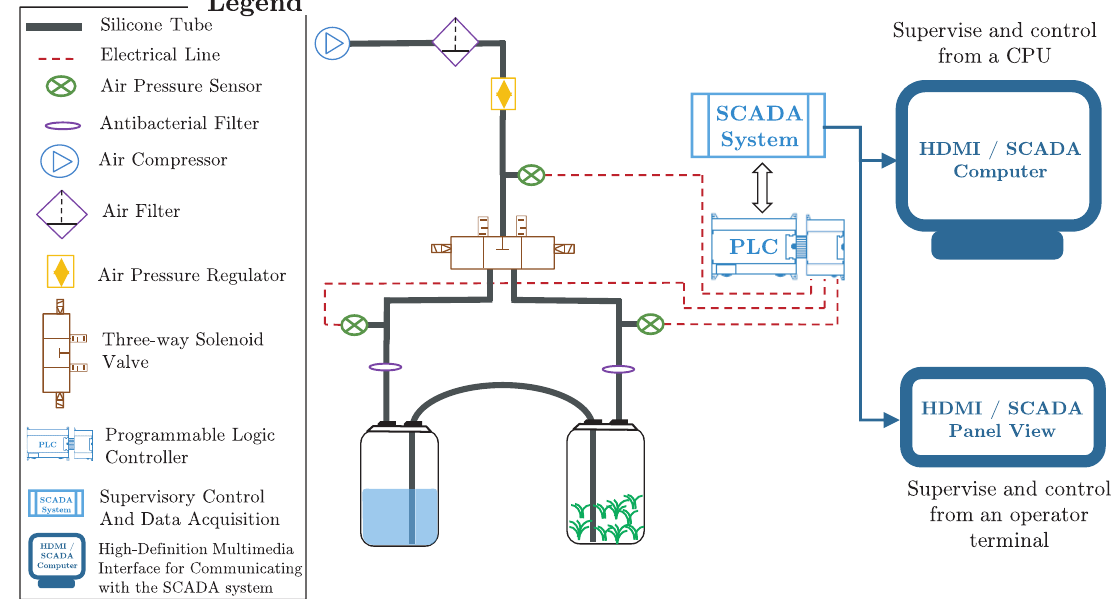
Figure 1. Temporary immersion bioreactor